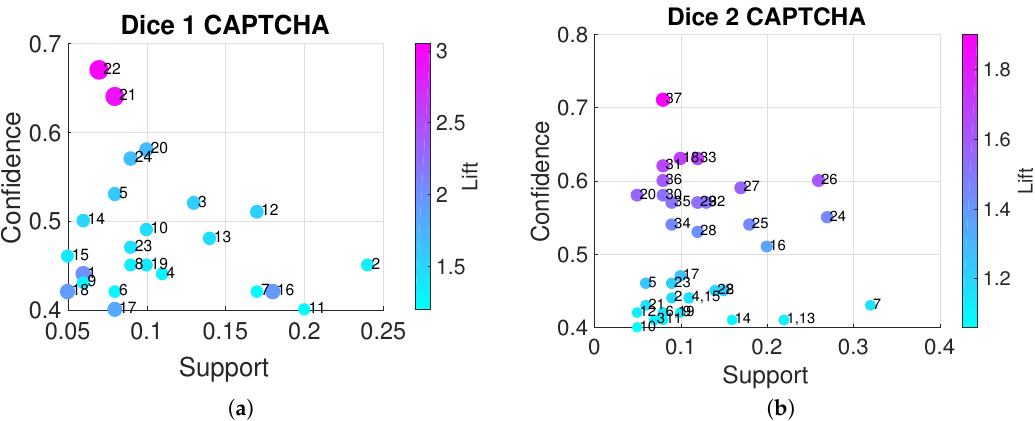
Figure 5. Scatter plot of the ARs given: (i) support; (ii) confidence; and (iii) lift, for Dice 1 and 2. Each coloured point represents an AR identified by its numerical ID (see Tables 1 and 2). The position x − y of each point depends on the support and confidence values of the corresponding AR. The colour of each point represents the lift value of the corresponding AR.